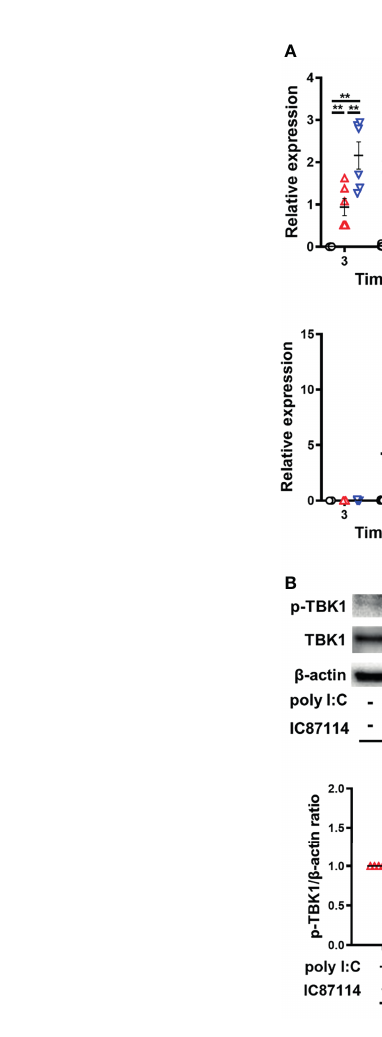
FIGURE 5 | A PI3K d inhibitor enhances poly I:C – induced antiviral IFN responses by promoting TBK1/IRF3 phosphorylation in PBECs. PBECs were pretreated with 10 m M IC87114 or vehicle for 1 h and then stimulated with 1 m g/mL poly I:C for the indicated times. (A) IFN b , IFN l 1, MxA, and ISG56 gene expressions were measured by real-time quantitative reverse-transcription PCR and normalized to that of 18S rRNA. Data represent means ± SEM (n=6 – 12 per group) and pooled from a minimum of two independent donors with three replicates. (B) Representative western blots showing phosphorylated TBK1, total TBK1, phosphorylated IRF3, and total IRF3 in PBECs. Band intensity was quantitated using densitometry. Data represent means ± SEM (n=7 per group) were pooled from four independent donors with two replicates. * p <0.05, ** p <0.001 by two-way